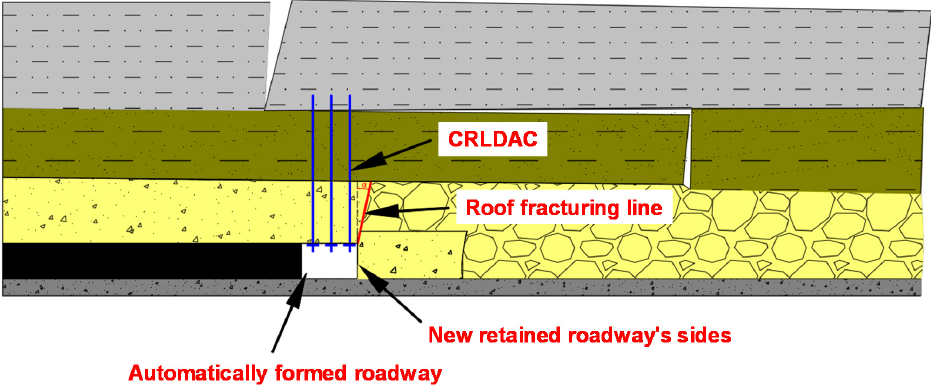
Figure 1. Section diagram of roof structure of gob-side entry retaining by roof cutting without pillar